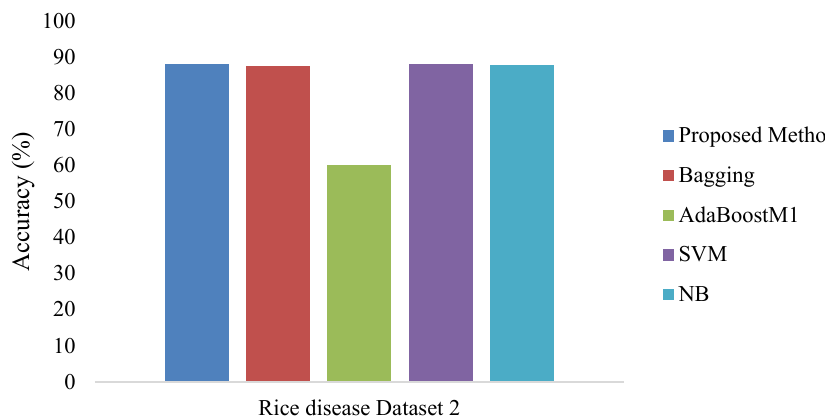
Figure 6. Accuracy for Rice disease dataset1 in the big data environment.